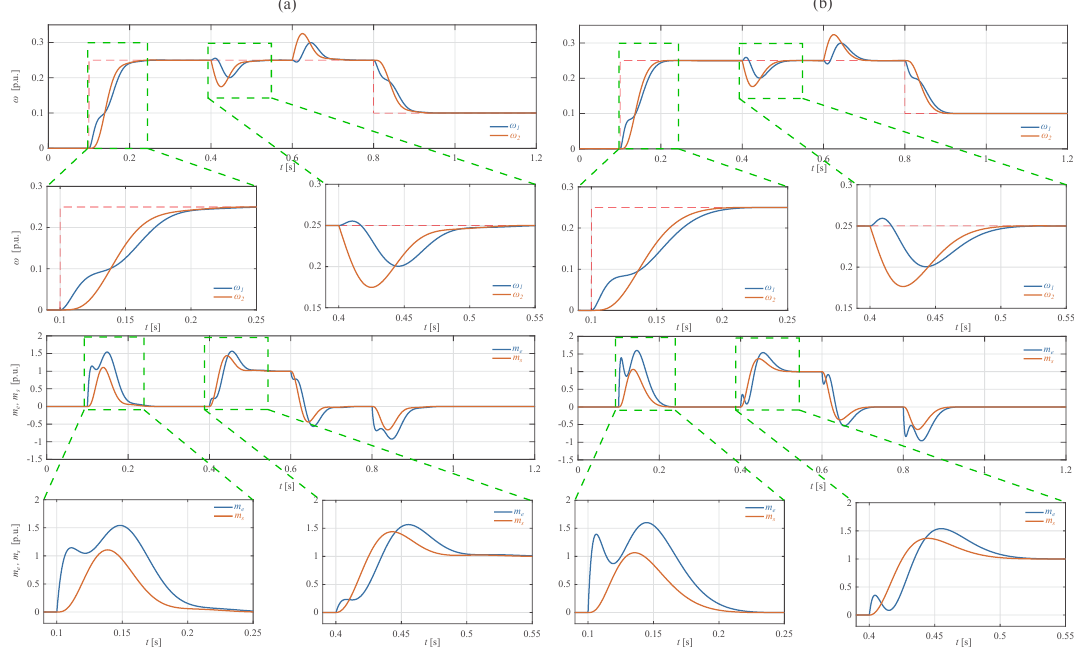
Figure 3. Step response for coefficients of SFC: ( a ) obtained for the ABC algorithm; ( b ) calculated analytically. From top: angular speed of the motor’s shaft and the system output, electromagnetic torque generated by the motor and torsional torque (simulation